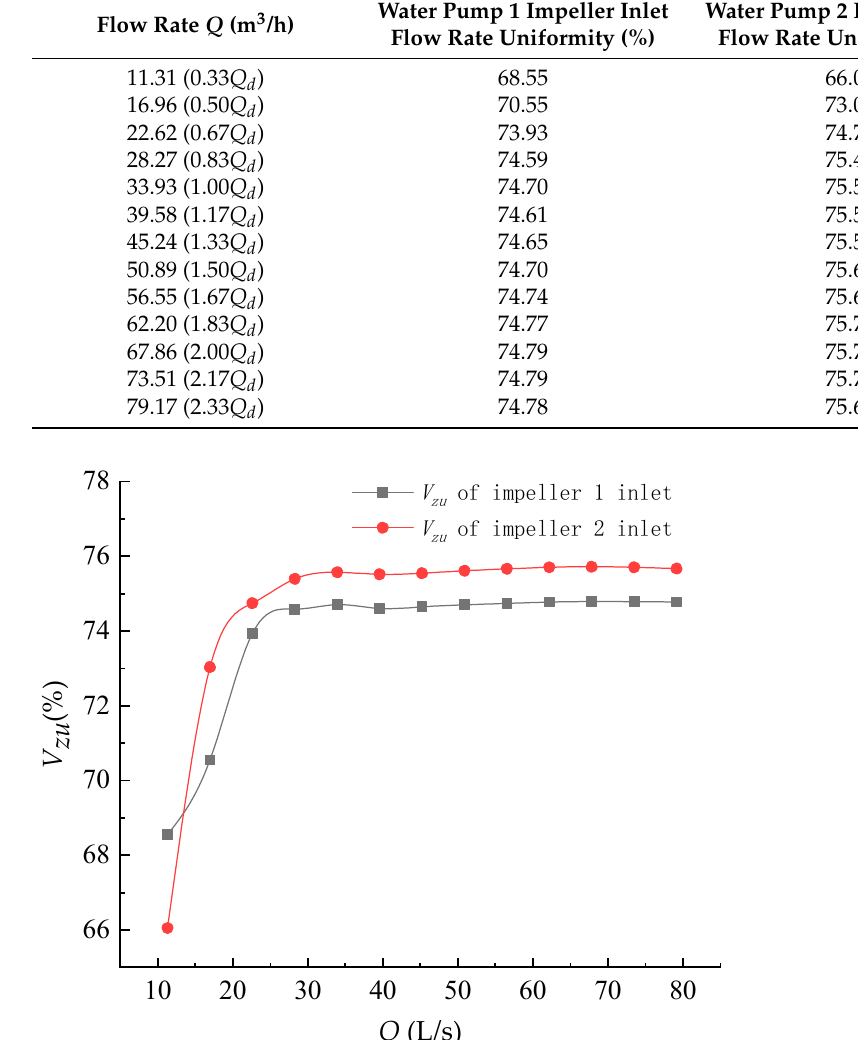
Figure 5. Uniformity of impeller inlet flow rate under different working conditions.